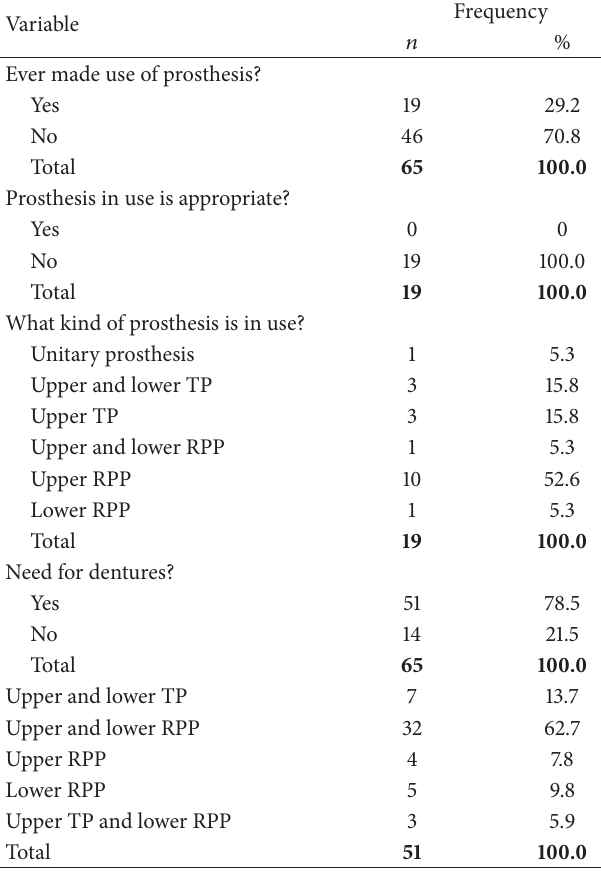
Table 5: Distribution of prisoners according to the use of and need for